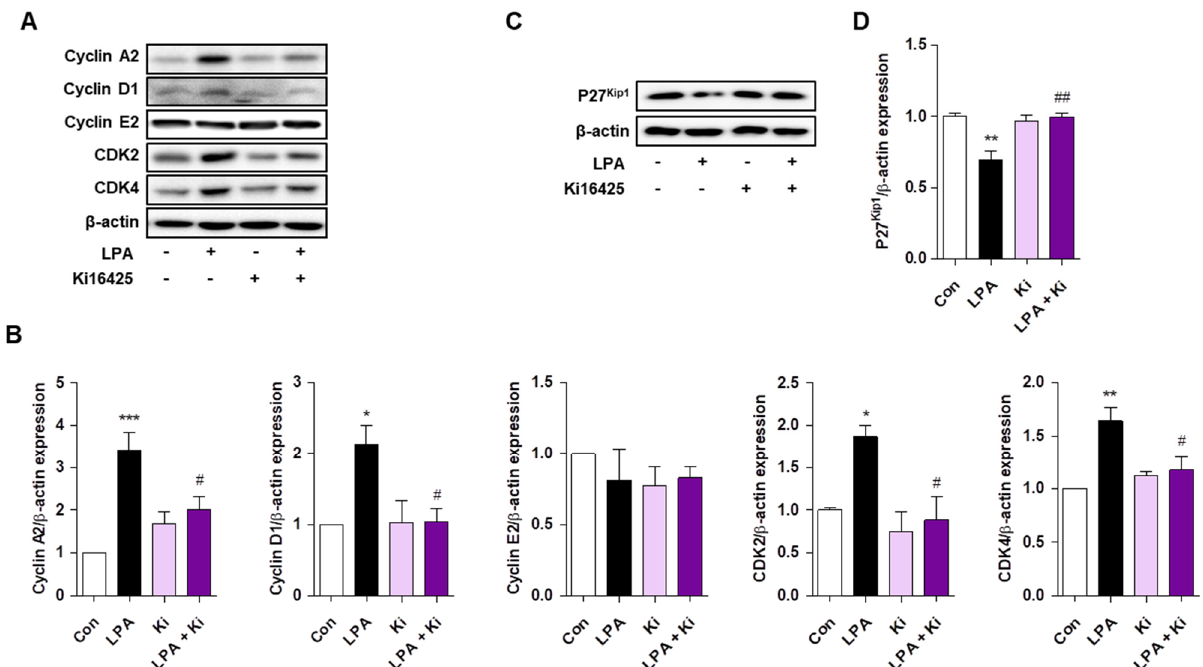
Figure 4. Ki16425 decreases lysophosphatidic acid (LPA)-induced expression of cyclin A2 and D1, CDK2, and CDK4 in HaCaT cells. HaCaT cells were seeded in 60-mm dishes and starved with serum-free media containing 0.1% fatty-acid-free bovine serum albumin (FAF-BSA) for 12 to 16 h. The cells were treated with 10 μ M LPA in the presence or absence of 10 µ M ki16425 for 6 h. Cyclin A2, D1, and E2, CDK2, CDK4, and p27 Kip1 protein levels were analyzed by Western blotting, quantified using ImageJ software, and normalized to those of β -actin. Representative images of the blots ( A , C ) and relative densitometric bar graphs ( B , D ) are shown. The data are presented as the mean ± standard error of the mean (SEM) of results obtained from three to four independent experiments. * p < 0.05, ** p < 0.01, *** p < 0.005 vs. Con; # p < 0.05, ## p < 0.01 vs. LPA.